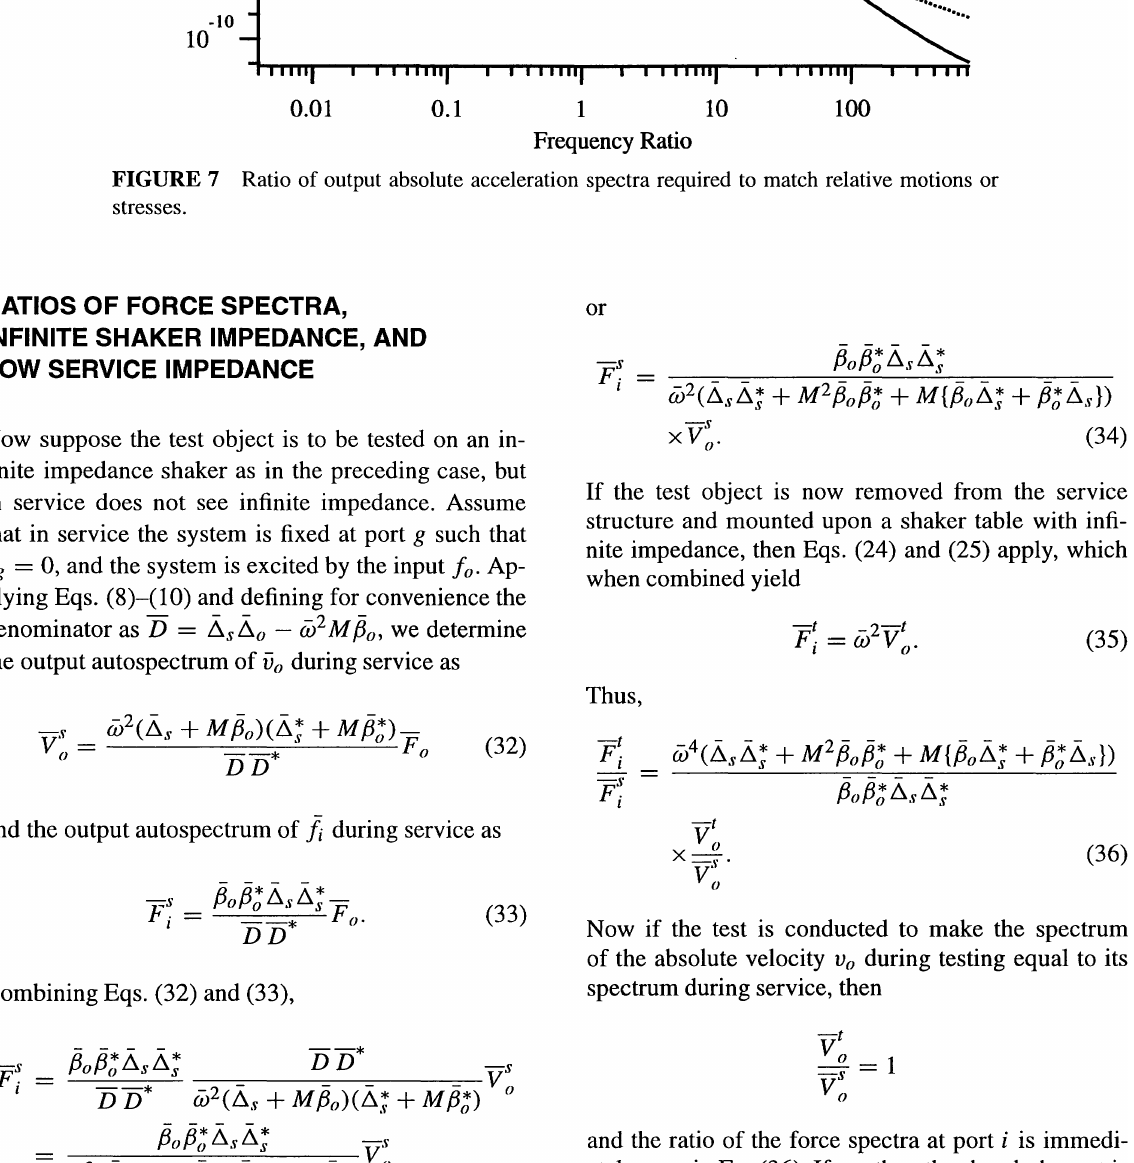
FIGURE 7 Ratio of output absolute acceleration spectra required to match relative motions or